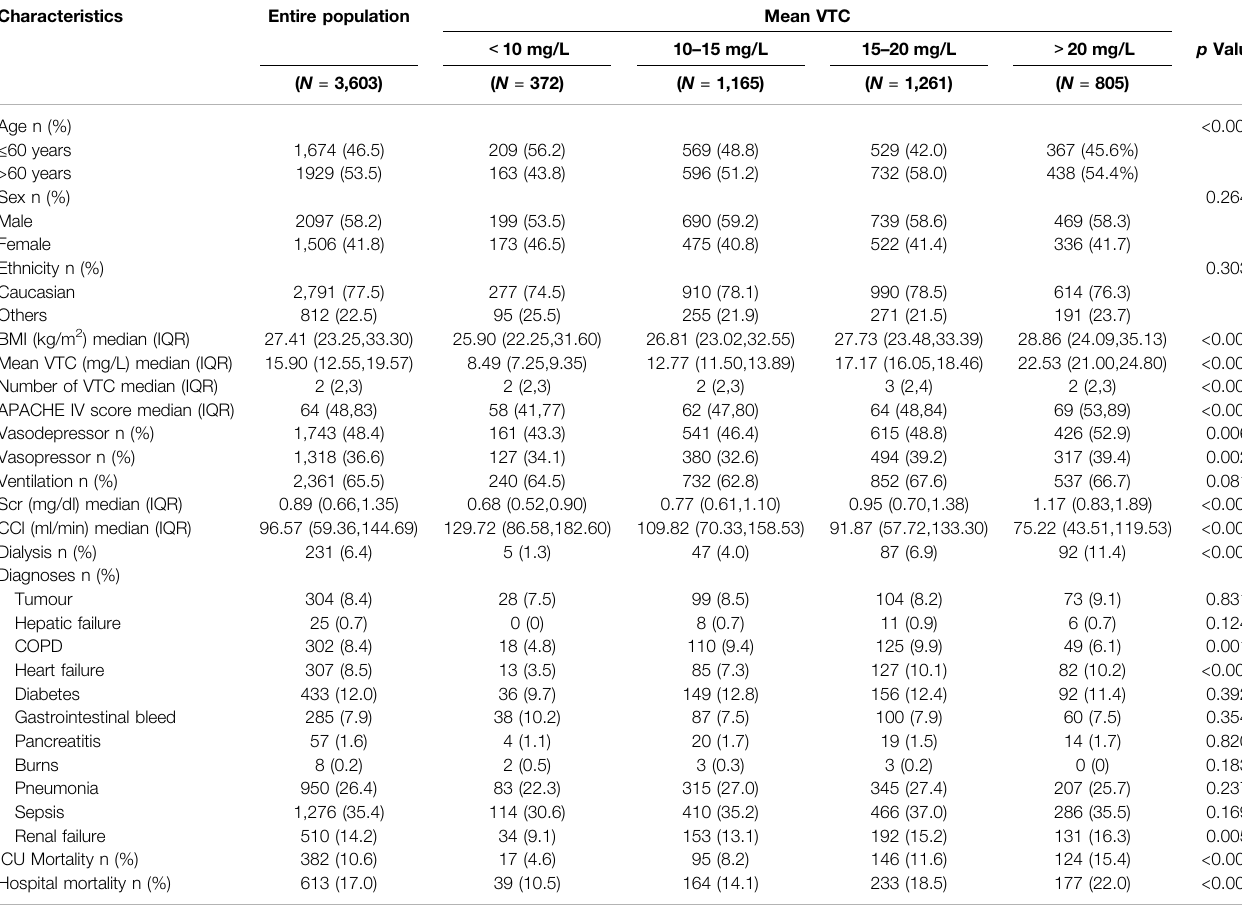
TABLE 1 | Baseline characteristics of the study cohort according to mean VTC categories.